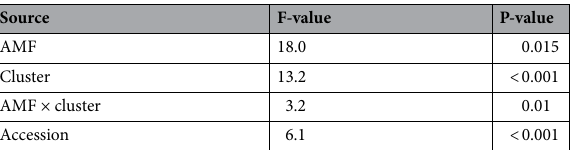
Table 1. Nested ANOVA results of the effect of arbuscular mycorrhizal fungal isolates (AMF), genetic cluster of Triticum turgidum (cluster), and wheat accession, on the level of host root mycorrhizal colonization.